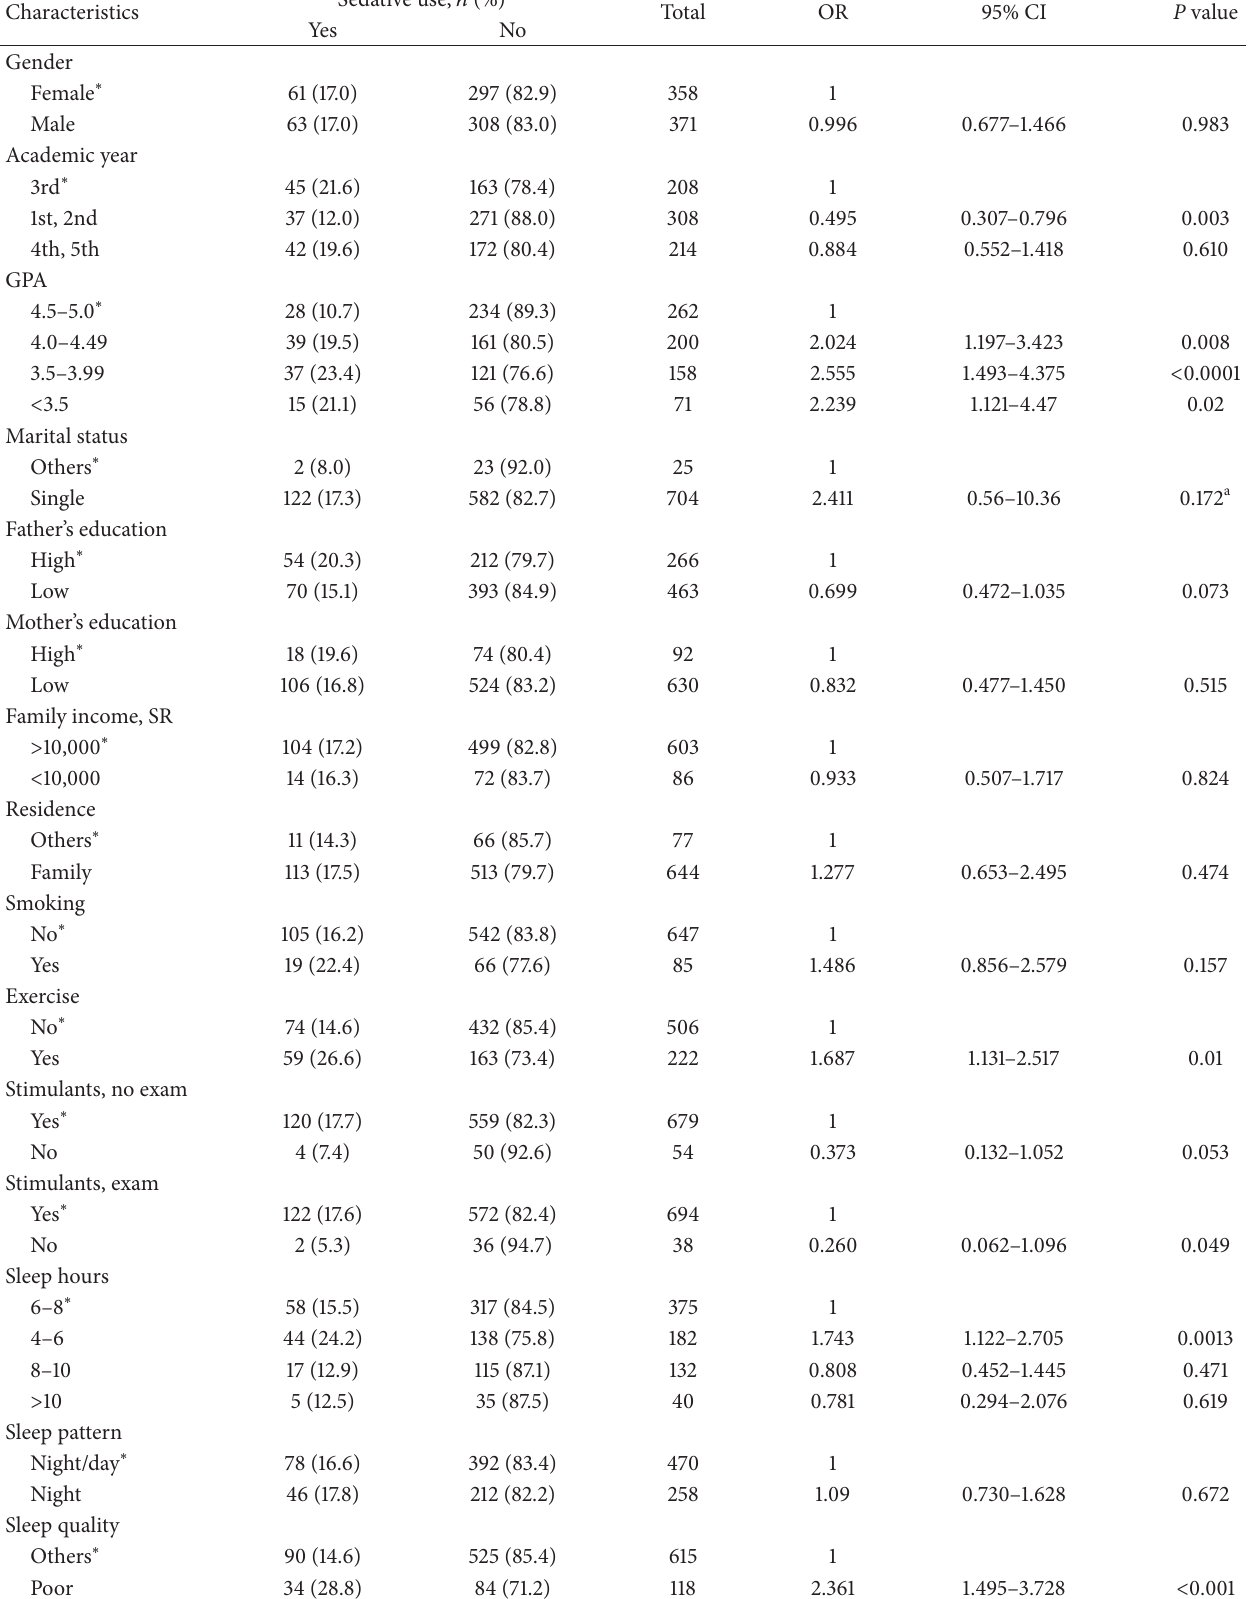
Table 1: Demographic, socioeconomic, and lifestyle characteristics of sedative drug users and nonusers.